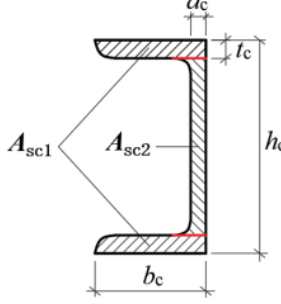
Figure 10. Cross-sectional drawing of channel. In Figure 10, h is the cross-sectional thickness of the tunnel lining; b is the longitudinal width of the tunnel